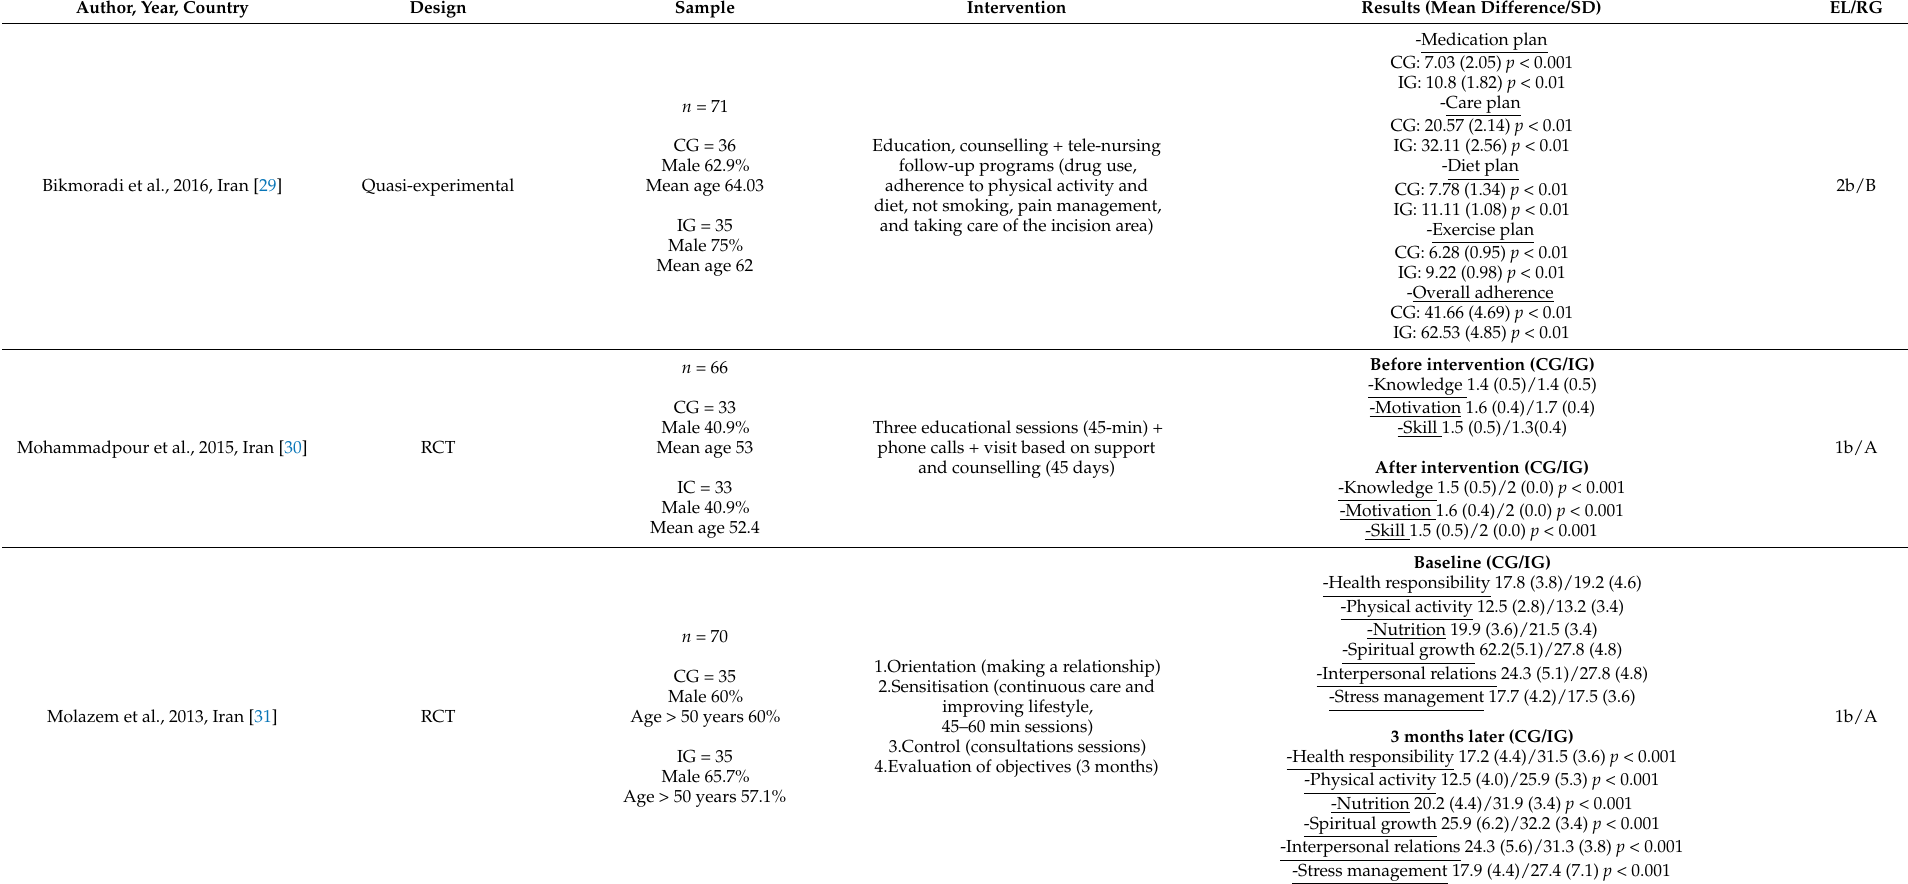
Table 1. Characteristics of included studies ( n =